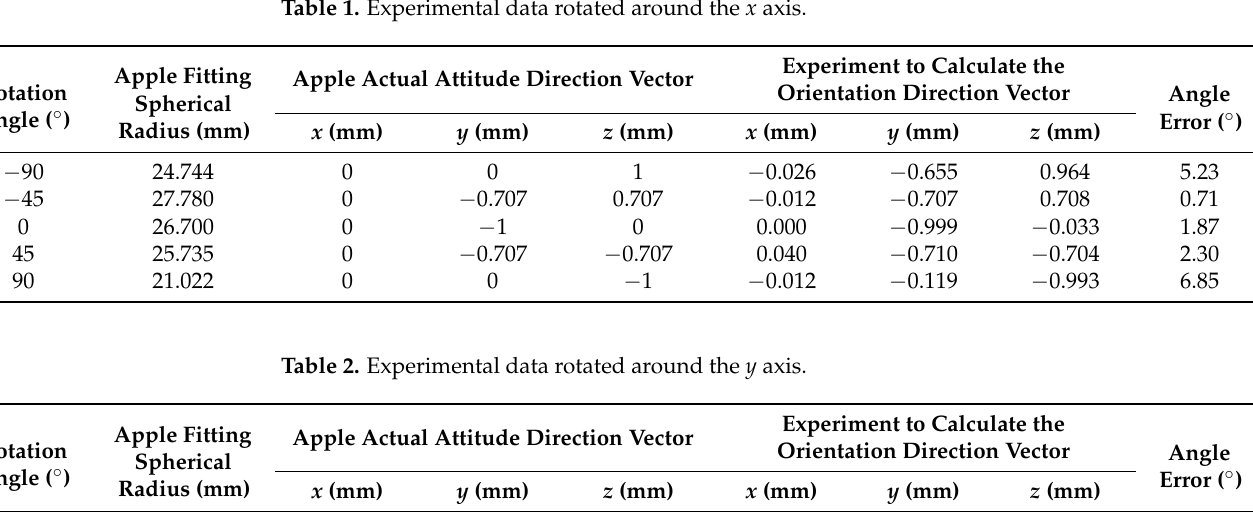
Table 1. Experimental data rotated around the x axis.